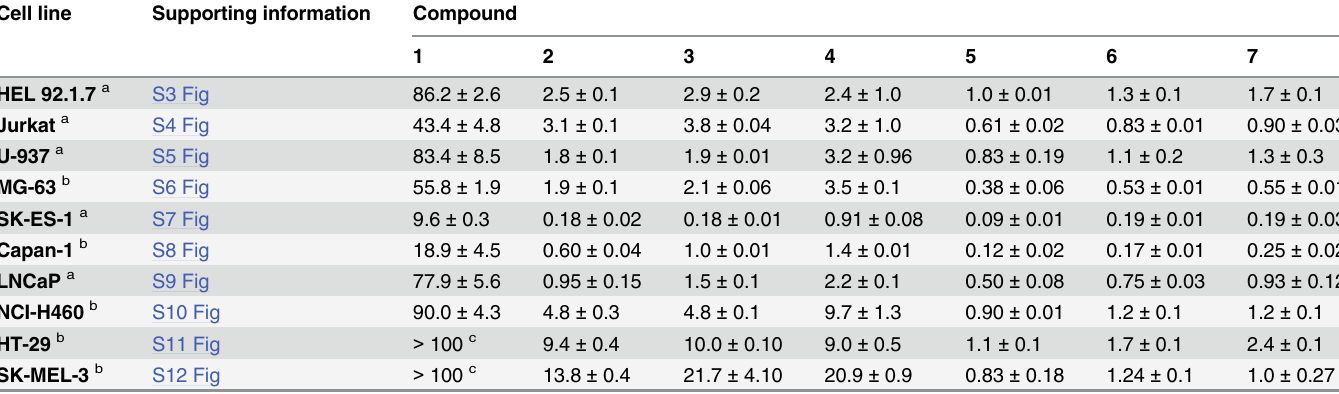
Table 1. Cytotoxicity of compounds 1 – 7 against selected human cancer cell lines of different origin. S ubgroups, representing hematological malig- nancies, sarcoma, carcinoma and malignant melanoma, are separated by horizontal lines. IC 50 values ( μ M) after 96 hours of